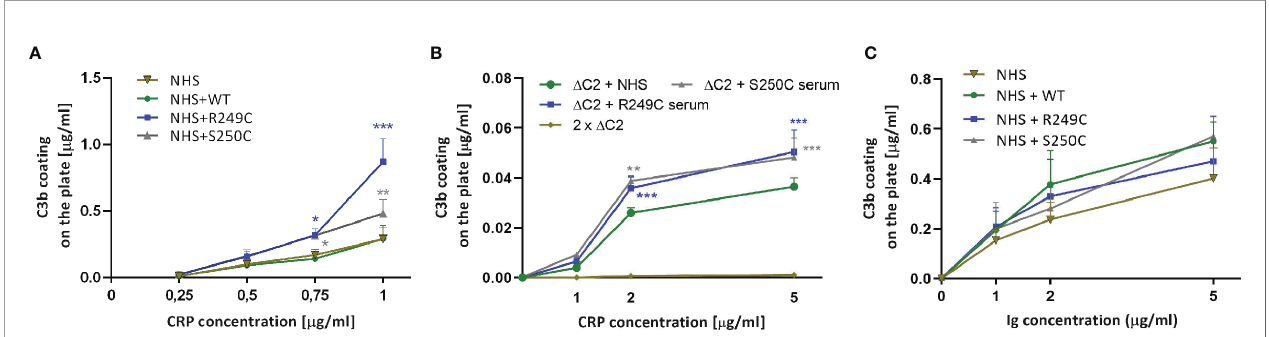
FIGURE 2 | C3b deposition assay in the presence of CRP and human Ig preparation. (A) Increasing concentrations of C-reactive protein (CRP) were coated onto the ELISA microplate and overlaid with 0.25% normal human serum (NHS) +/ − recombinant C2 variants. After 30 min incubation, C3b deposition was detected by anti-C3b antibody. Puri fi ed C3b directly coated on the plate was used as a standard. (B) The same assay was performed with a 1:1 mix of D C2 serum with patients ’ sera or NHS as a control. (C) ELISA plates were coated with a preparation of human Ig (pentaglobin) instead of CRP and overlaid with NHS with recombinant C2 variants. Differences between the given C2 variant and the WT were analyzed by Dunnett multiple comparison test for non-repeated measures. * P < 0.05; ** P < 0.01; *** P <